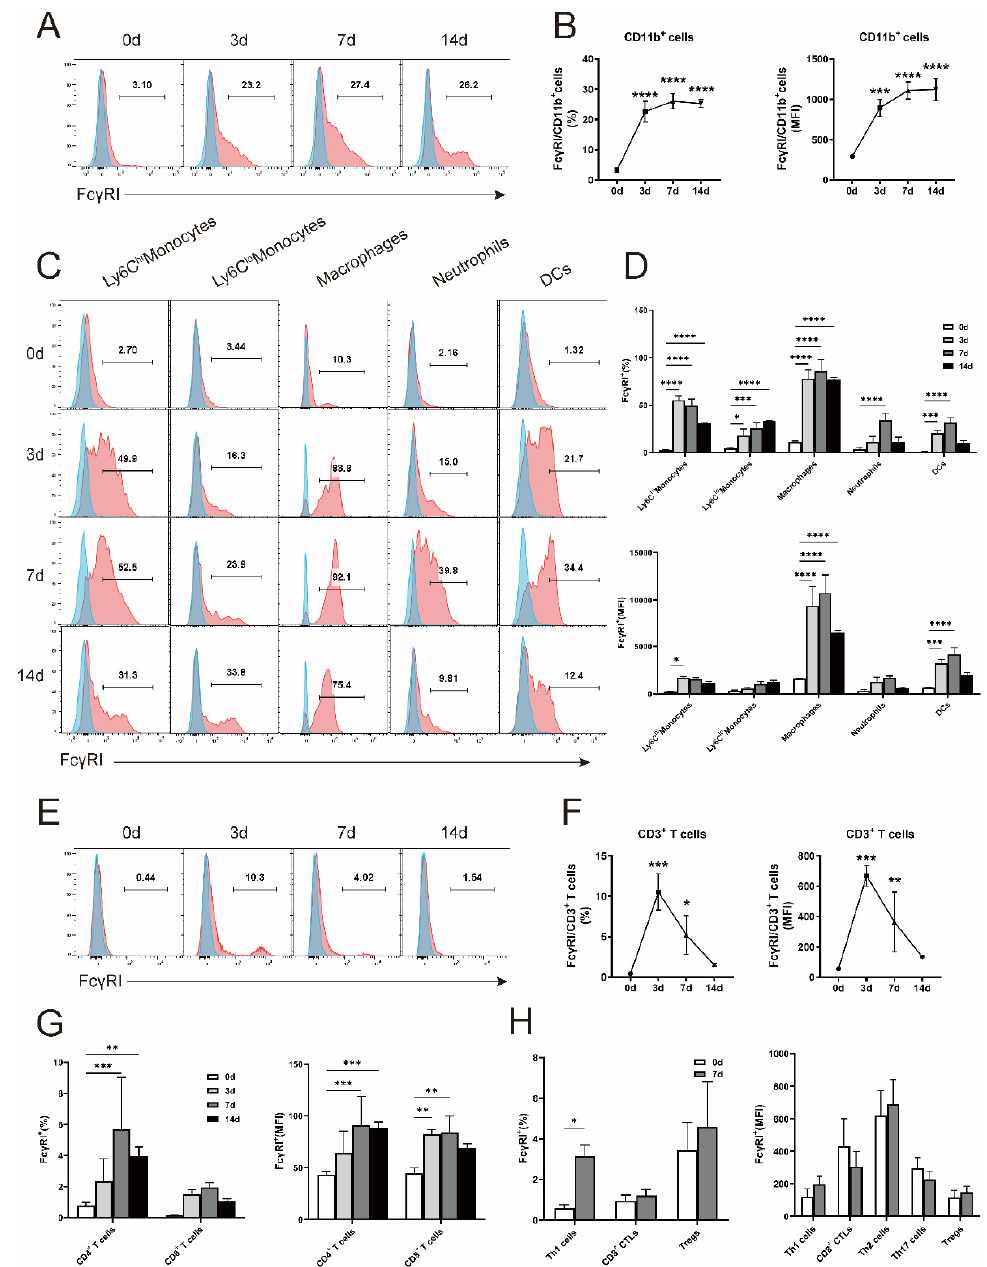
Figure 2. Increased expression of FcγRI in innate and adaptive immune cells after infection. The WT mice were intranasally infected and euthanized at days 0, 3, 7, and 14 p.i., lung single cells were prepared and flow cytometry was performed to determine the FcγRI expressions (red) with fluorescence minus one (FMO) control (blue) on gated cells as described in Supplementary Figure S1. Representative flow cytometric images ( A , C , and E ), the percentages and mean fluorescence intensity (MFI) of FcγRI + cells on the CD11b + cells ( B ), Ly6Chi monocytes, Ly6C lo monocytes, macrophages, neutrophils, and DCs ( D ), as well as on the CD3 + T cells ( F ), CD4 + and CD8 + T cells ( G ), CD4 + IFN−γ + Th1, CD8 + IFN−γ + CTL, CD4 + IL−4 + Th2, CD4 + IL−17 + Th17, and CD4 + FoxP3 + Treg ( H ) were shown. Data are represented as means ± SD from n = 3–6 per group, representative of one of three independent experiments. Statistical significances of differences are determined by one-way ANOVA ( B and F ) and two-way ANOVA ( D , G , and H ). * p < 0.05, ** p < 0.01, *** p < 0.001, **** p < 0.0001.